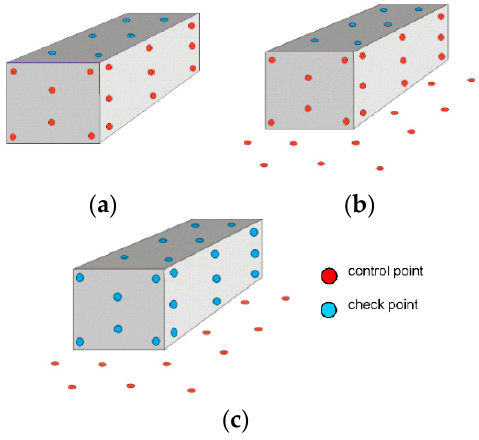
Figure 9. Three configurations of control points and tie points: ( a ) I—control points on the facade; ( b ) II—control points on the facade and around the object; ( c ) III—control points around the object. Table 6. Angular exterior orientation parameters calculated based on measuring control points distributed in different configurations.